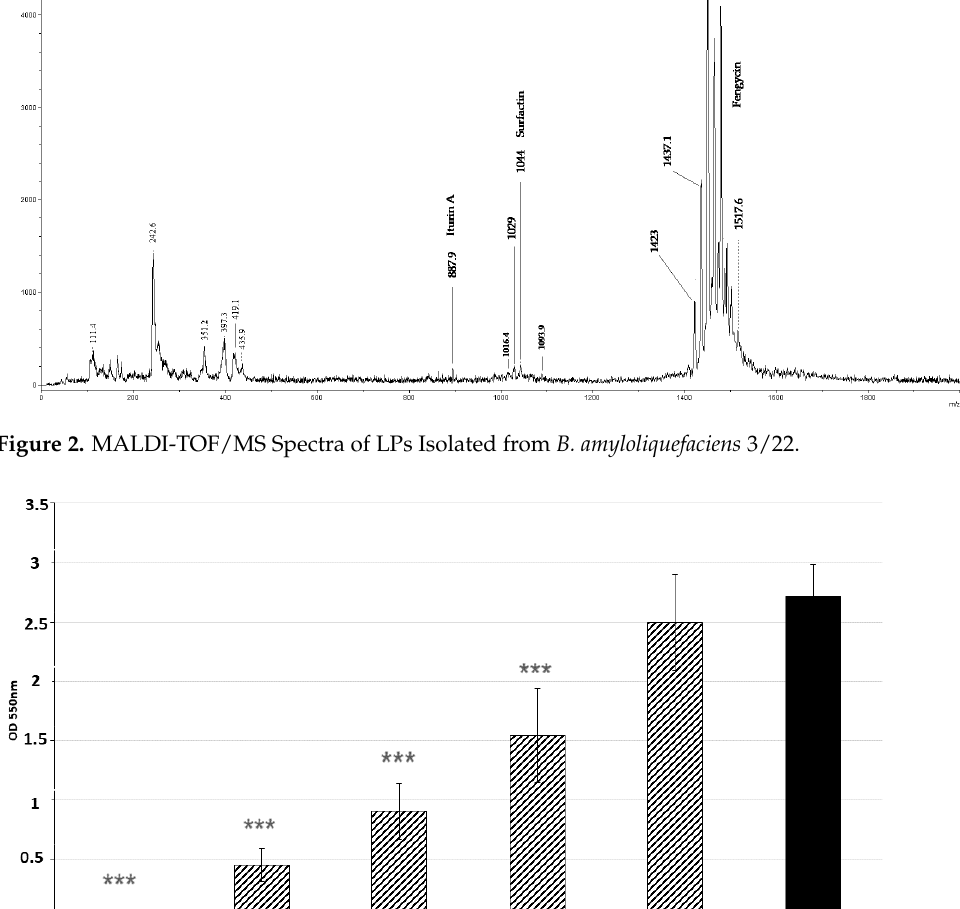
Table 2. The percentage of inhibition of biofilm formation by S. aureus CCM 4223. Figure 3. The effect of LPs 3/22 on S. aureus CCM 4223 biofilm formation. Control— S. aureus CCM 4223 in mBHI broth (brain heart infusion) without LPs 3/22; data are presented as the means ± standard deviation; *** ( p < 0.001)—significant difference compared to the non-treated control.